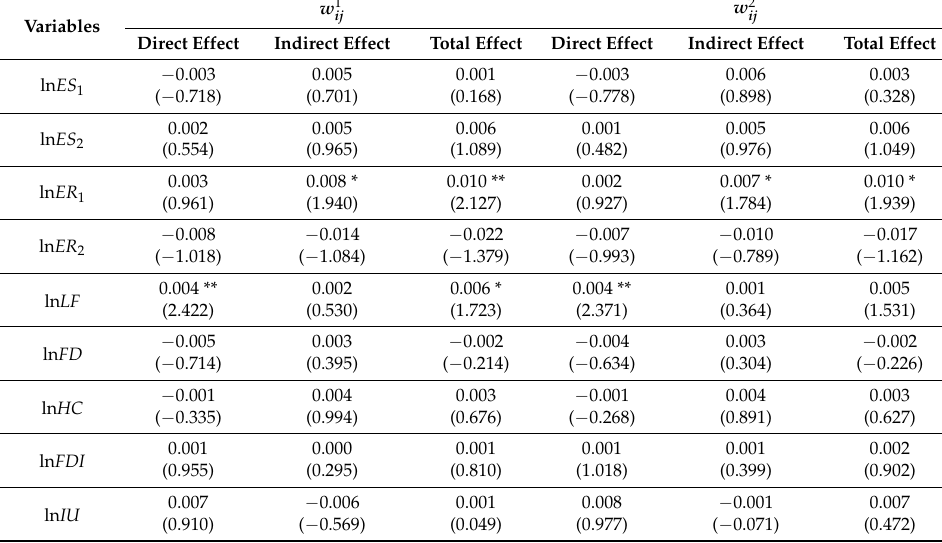
Table 9. The direct, indirect and total effects of the western